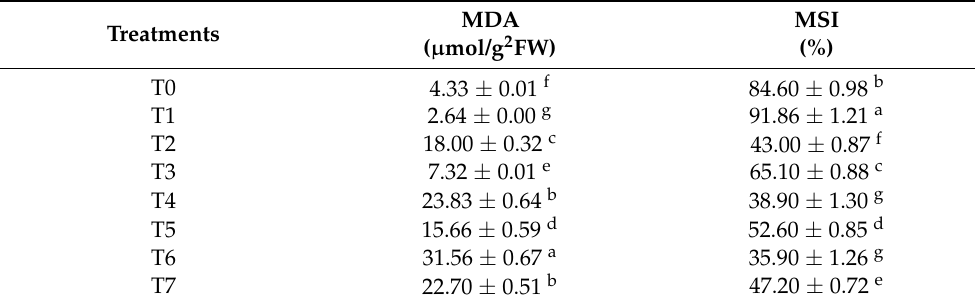
Table 5. Effect of chromium stress and B. cereus inoculation on malondialdehyde content and membrane stability index of B. nigra .